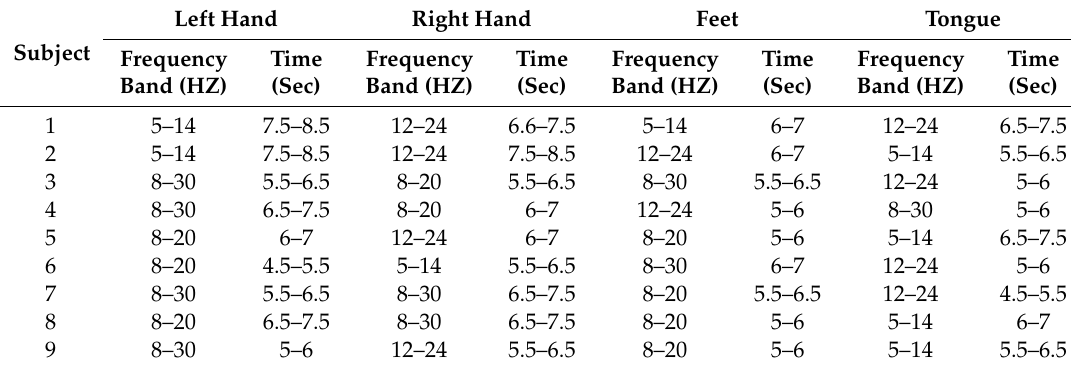
Table 1. Frequency band and their respective